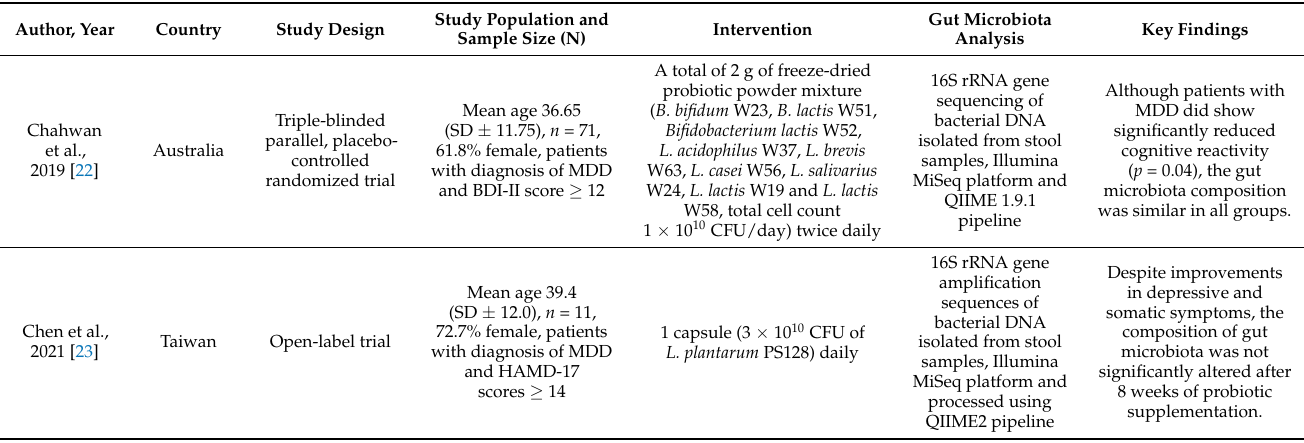
Figure 1. PRISMA flowchart showing the study abstraction process. Table 1. Relevant characteristics and findings of the studies reviewed (arranged alphabetically by the first author’s last name).